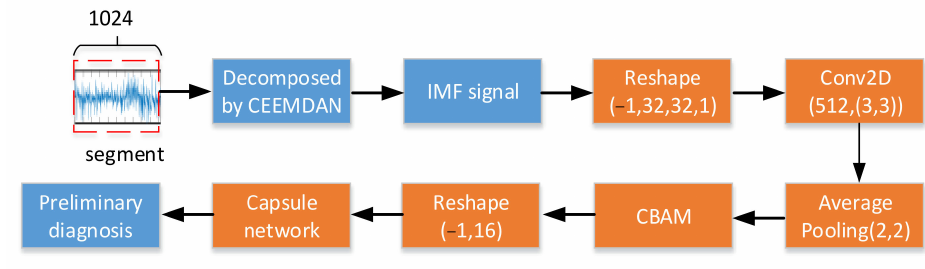
Figure 5. The architecture of Capsnet with